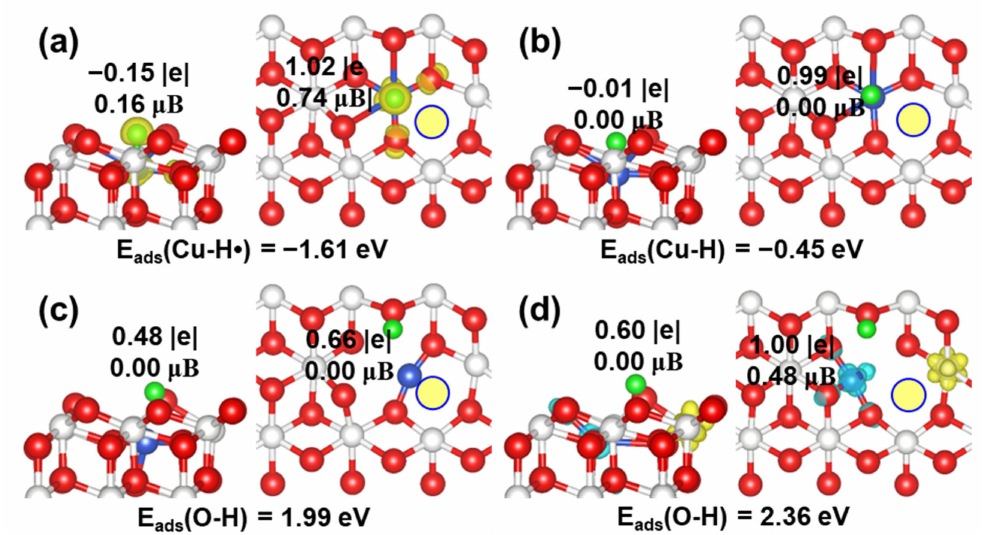
Figure 2. Calculated structures (left: side view; right: top view) of H adsorption at ( a , b ) Cu and ( c , d ) O sites of the Cu/CeO 2 (111) surface. The calculated adsorption energies of H, Bader charges and the magnetic moments of H (left) and Cu (right), and spin density distributions (in yellow) are also